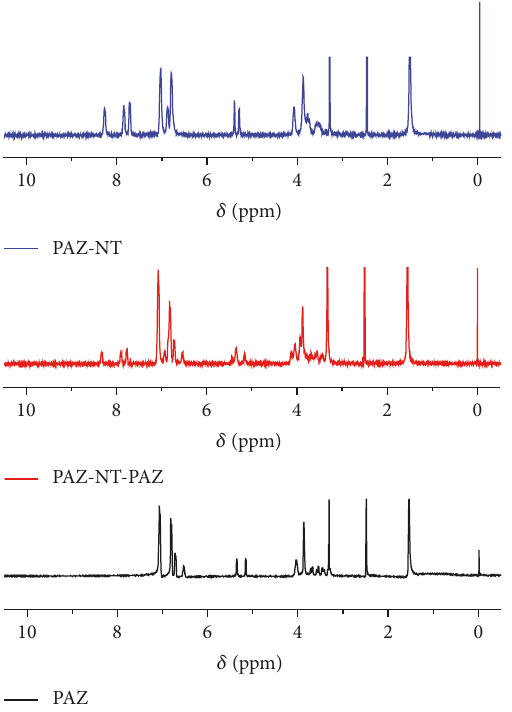
Figure 6: 1 H NMR spectra of the PAZ, PAZ-NT, and PAZ-NT-PAZ.